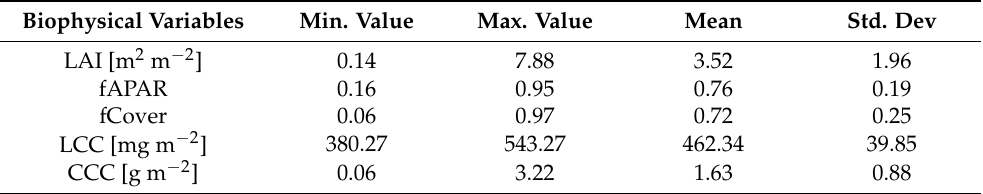
Table 5. Descriptive statistics for the biophysical variables of winter wheat crops (BBCH 22 to 26, BBCH 31 to 33, and BBCH 65 to 69) measured in the Zlatia site during three field campaigns in the agricultural year 2016/2017, n = 80. Biophysical Variables Min. Value Max. Value Mean Std. Dev LAI [m 2 m − 2 ] fAPAR